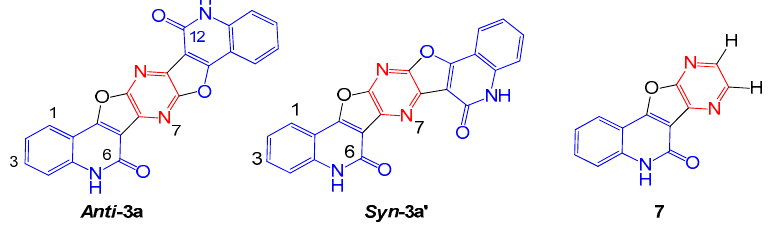
Figure 3. Alternative structures of compound 3a [14–20] (Reproduced with permission from [14–20]).